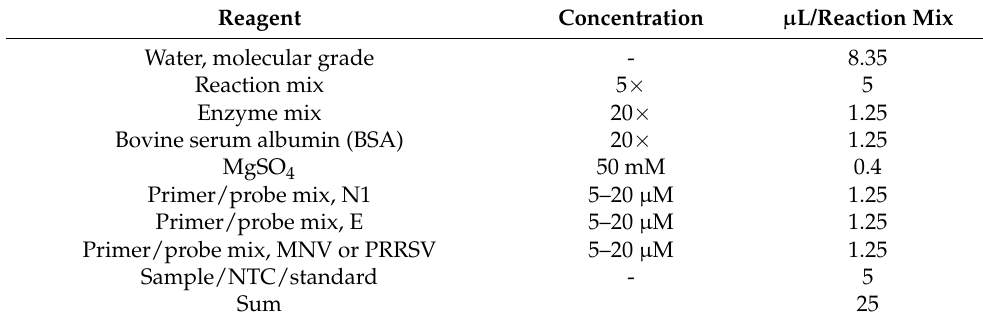
Table 2. qRT-PCR reaction mix. Primer/probe mix compositions are detailed in Section 5.